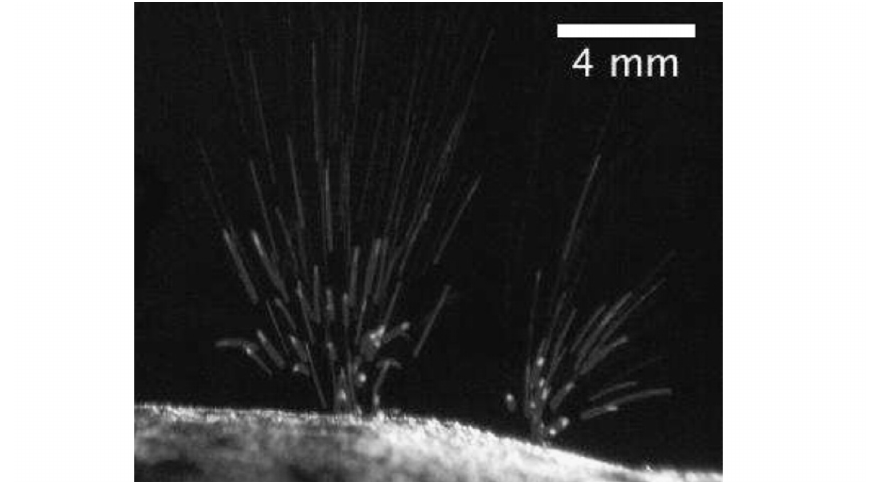
Figure 9. Grains that were eruptively ejected from an illuminated surface at a low ambient pressure (from Kelling and Wurm